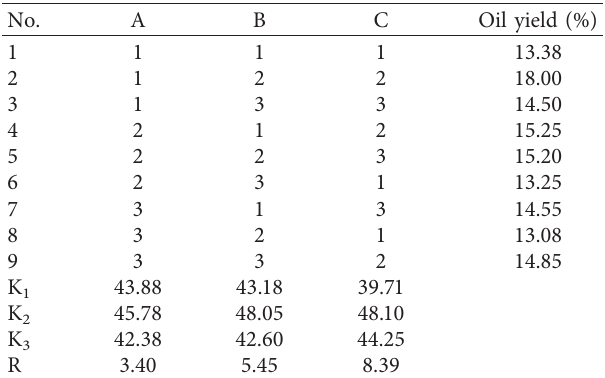
Table 4: Orthogonal experimental design and results of ultrasonic- assisted extraction of palm seed